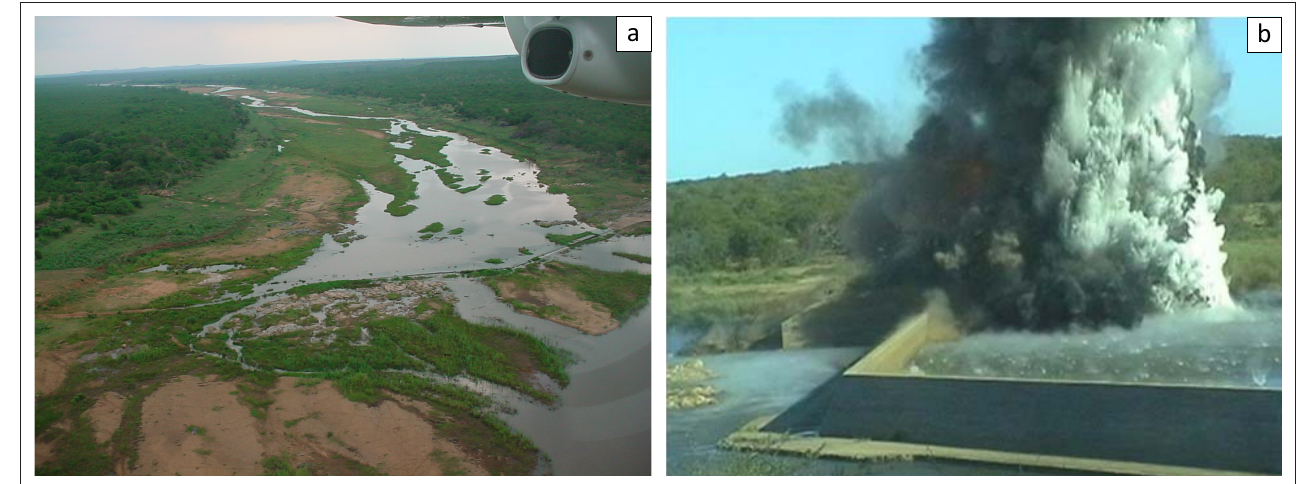
FIGURE 2: (a)The Shimuwini Dam and (b) its removal in